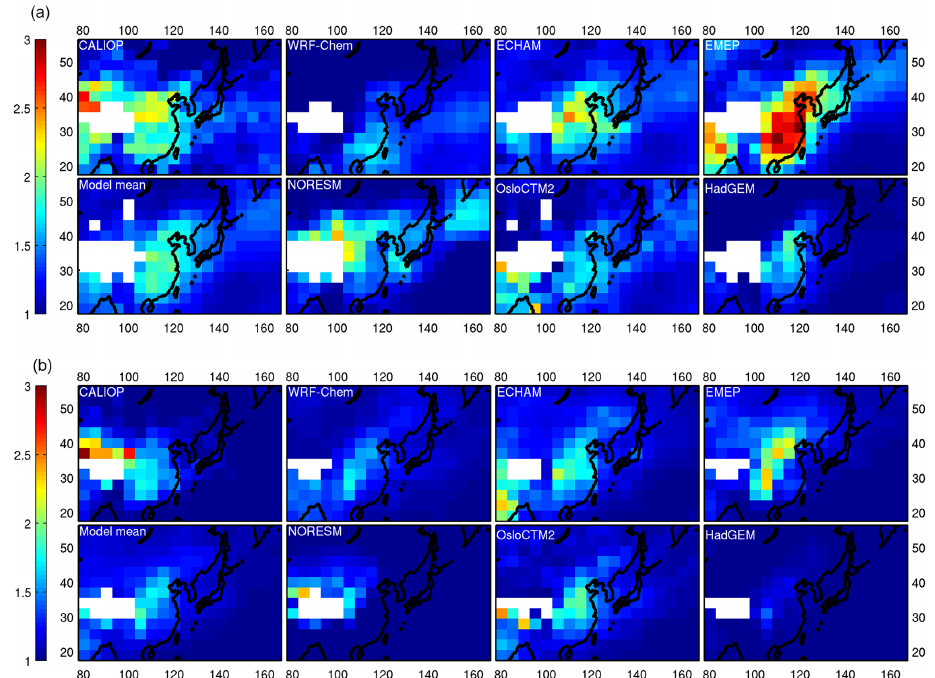
Figure 10. (a) Comparison between apparent scattering ratio ( R app ) over Asia in August and September 2008 averaged over a 0–2km layer derived from CALIOP data and simulated by the ECLIPSE models. White boxes indicate missing observations due to ground elevation. (b) Comparison between apparent scattering ratio ( R app ) over Asia in August and September 2008 averaged over a 2–4km layer derived from CALIOP data and simulated by the ECLIPSE models. White boxes indicate missing observations due to ground